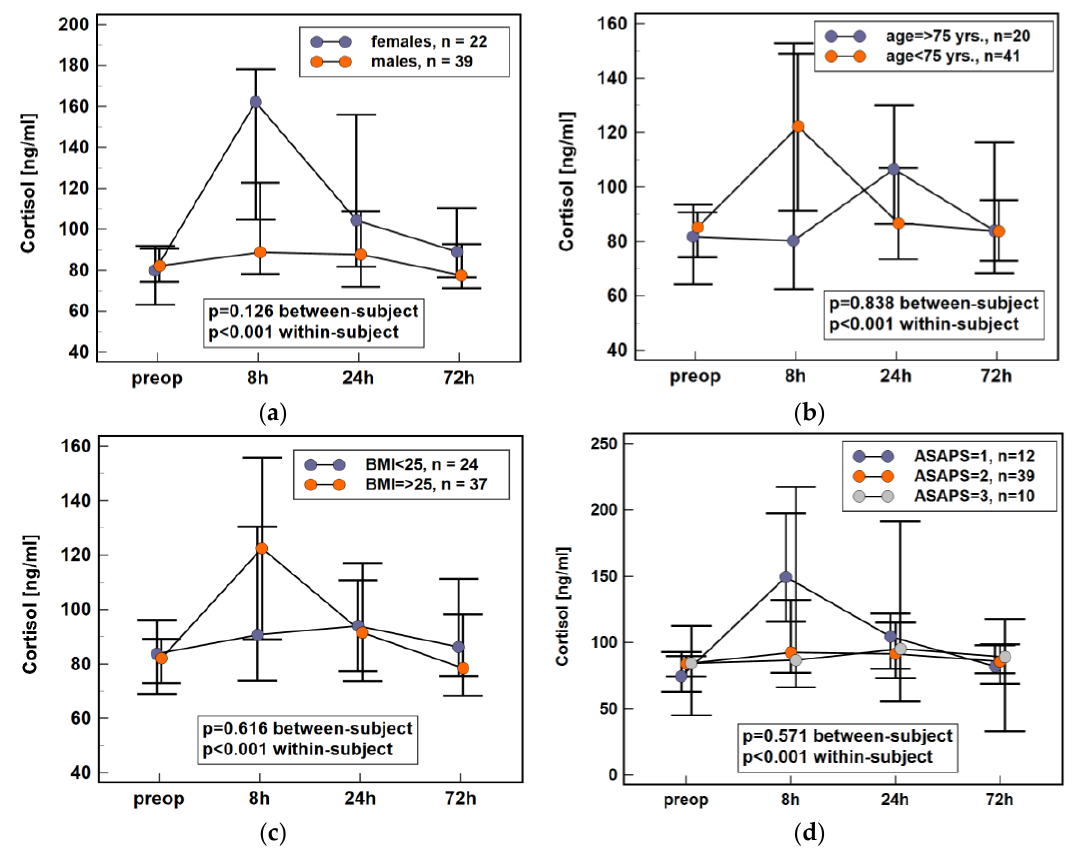
Figure 2. Impact of various patient characteristics on plasma cortisol dynamics in early postoperative period following colorectal surgery: ( a ) sex; ( b ) age; ( c ) body mass; ( d ) health status. Data presented as medians with 95% CI. Data were analyzed following log-transformation using repeated measures analysis of variance with p values indicating significance of between-subjects (sex, age, body mass, and ASAPS) and within-subjects (time points) effects ( n = 61). BMI, body mass index; yrs., years; ASAPS, the American Society of Anesthesiologists physical status classification system; CI, confidence interval; preop, preoperative; 8 h, 8 h post-incision; 24 h, 24 h post-incision; 72 h, 72 h post-incision.